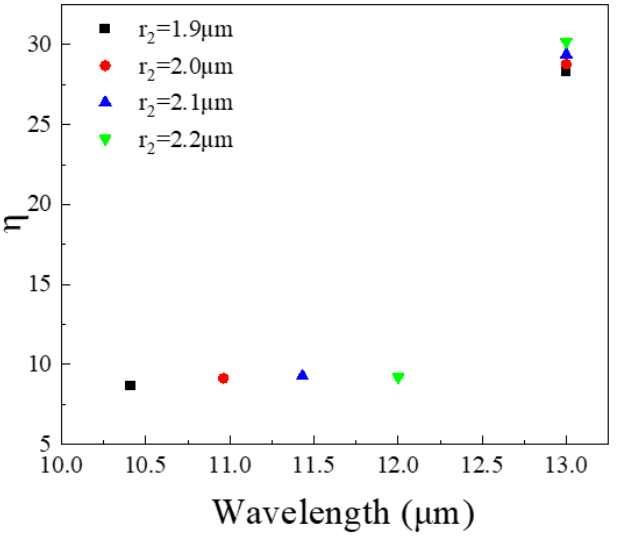
Figure 9. In the wavelength range of 10.5–15 µ m, the maximum coupling efficiency corresponding to different r 2.